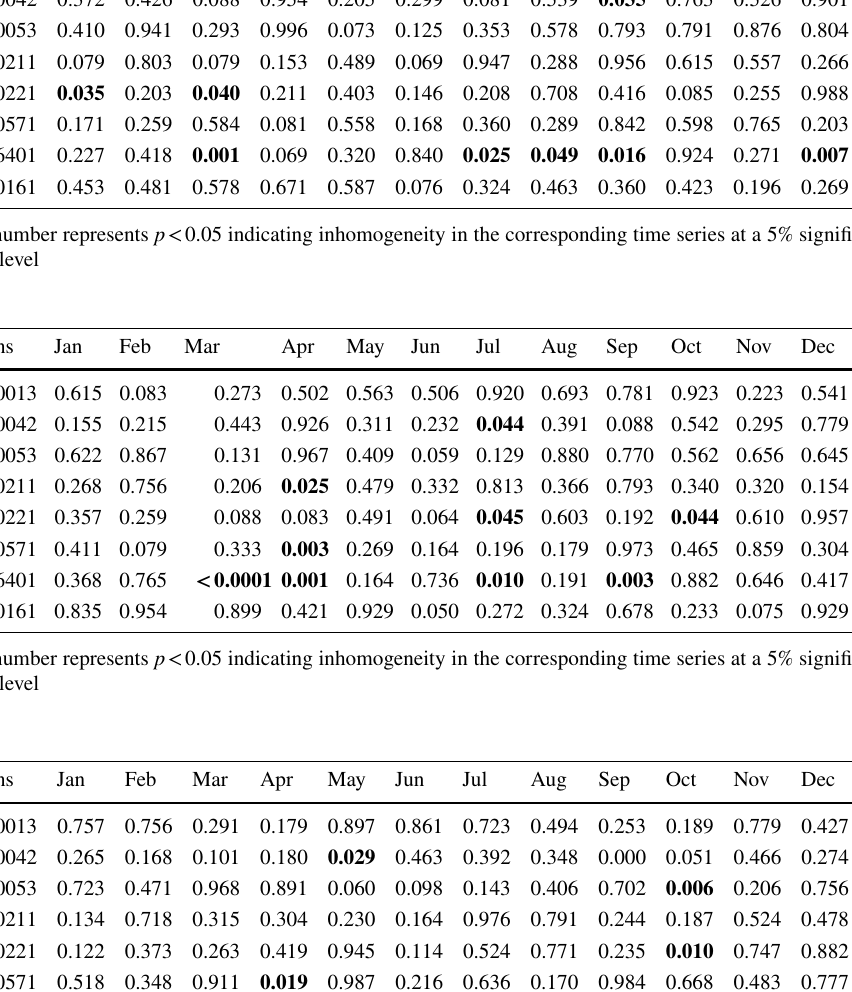
Table 3 The p values obtained from SNHT for each calendar month and station